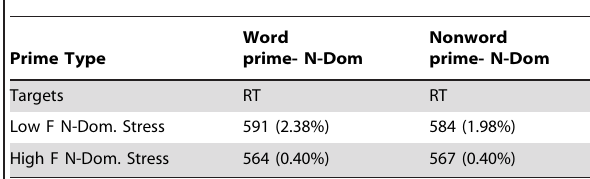
Table 5. Mean response latencies (RT) as a function of prime type and target type and percentages of stress errors (in parentheses) in Experiment